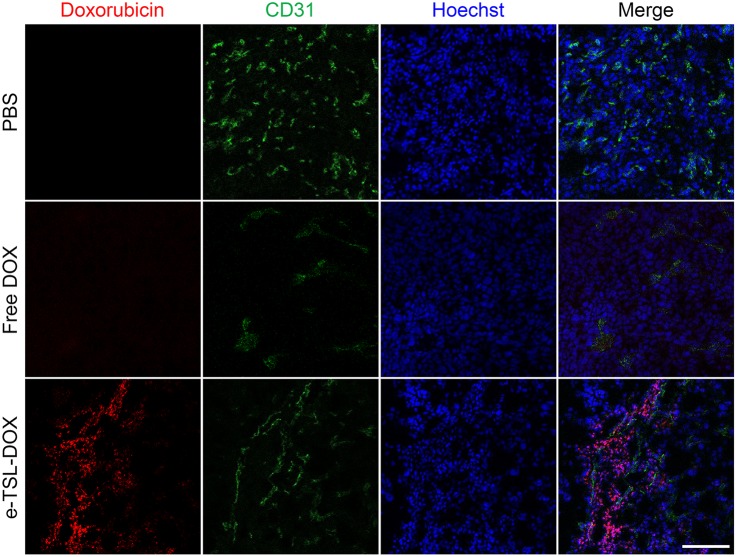
Intratumoral distribution of DOX. Red, DOX; green, CD31 (endothelial marker); blue, Hoechst (nuclear marker). Scale bar, 100 µm.